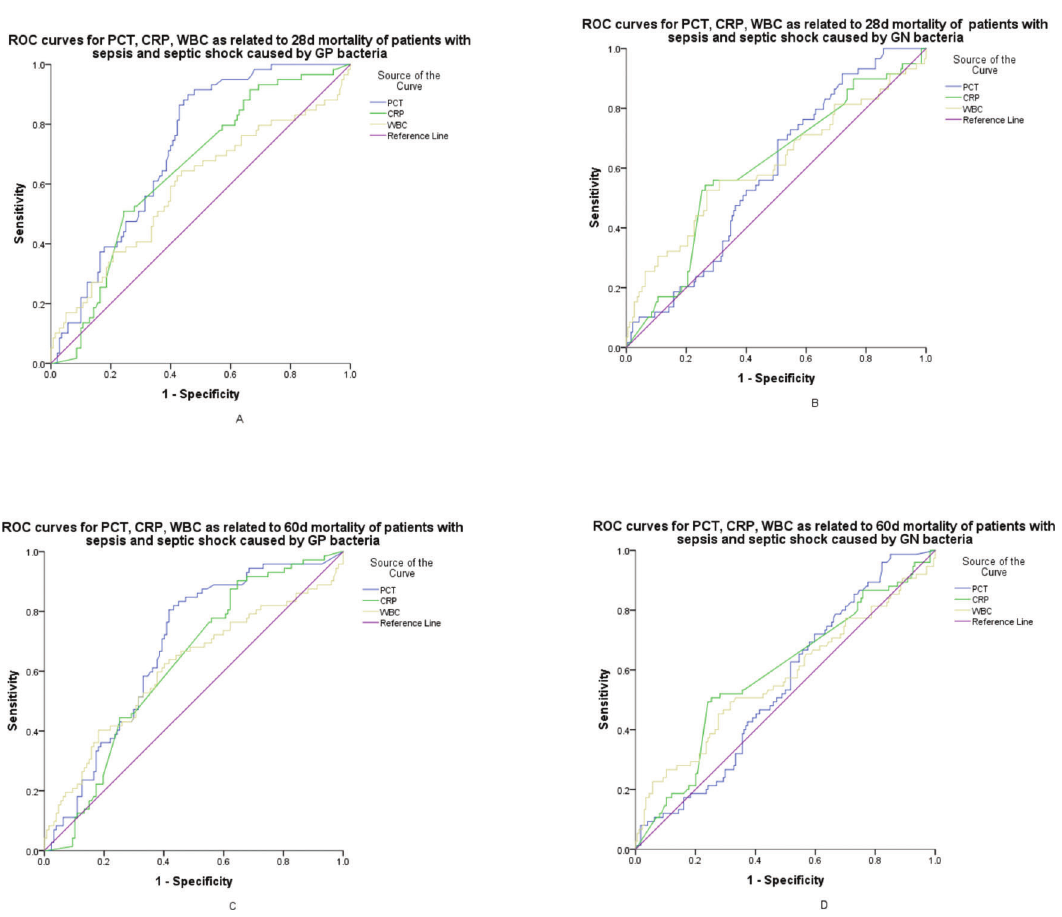
Figure 3 - ROC curves for serum PCT, hs-CRP, and WBC. A: AUC demonstrates that serum PCT measures 0.718 (95% CI, 0.648–0.788), hs-CRP measures 0.614 (95% CI, 0.543–0.682), and WBC measures 0.588 (95% CI, 0.497–0.679) for the prognosis of early mortality of patients with sepsis and septic shock caused by GPB infections. B: AUC demonstrates that serum PCT measures 0.583 (95% CI, 0.507– 0.659), hs-CRP measures 0.603 (95% CI, 0.520–0.686), and WBC measures 0.608 (95% CI, 0.518–0.697) for the prognosis of early mortality of patients with sepsis and septic shock caused by GNB infections. C: AUC demonstrates that serum PCT measures 0.678 (95% CI, 0.603– 0.753), hs-CRP measures 0.600 (95% CI, 0.529–0.669), and WBC measures 0.587 (95% CI, 0.515–0.656) for the prognosis of late mortality in patients with sepsis and septic shock caused by GPB infections. D: AUC demonstrates that serum PCT measures 0.547 (95% CI, 0.473– 0.621); hs-CRP, 0.588 (95% CI, 0.510–0.667), and WBC measures 0.570 (95% CI, 0.487–0.652) for the prognosis of late mortality of patients with sepsis and septic shock caused by GNB infections. ROC, receiver operating characteristic; PCT, procalcitonin; hs-CRP, high- sensitivity C-reactive protein; WBC, white blood cell; AUC, area under the curve; CI, confidence interval; GPB, gram-positive bacteria; GNB, gram-negative